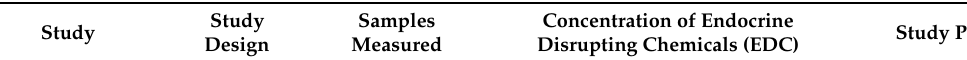
Table 3. Exposure to parabens and